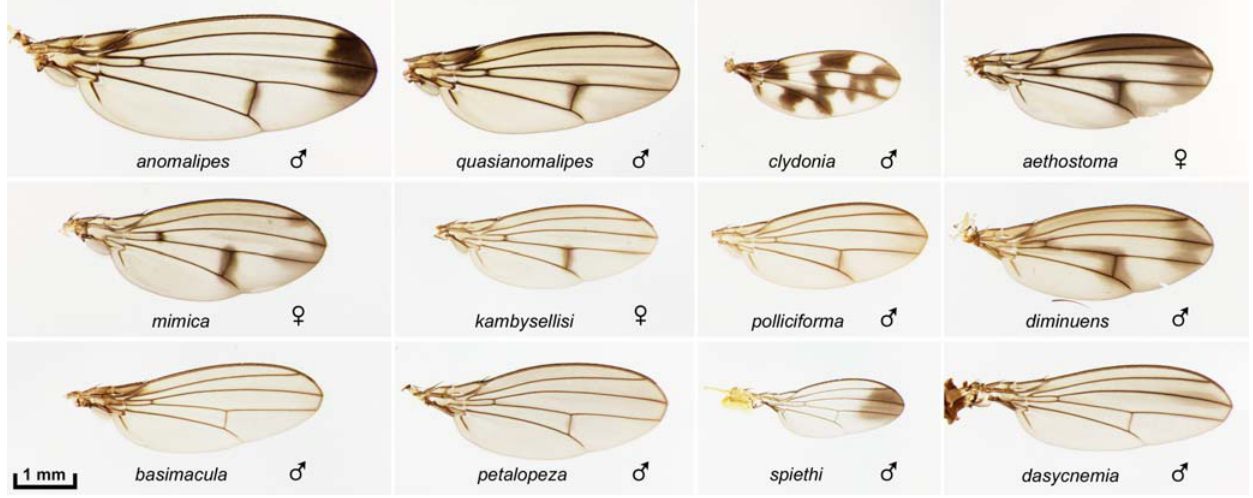
Figure 7. Other non-picture wing species. The anomalipes group: anomalipes and quasianomalipes . ‘‘Modified mouthparts group’’: clydonia, aethostoma, mimica, kambysellisi, polliciforma , and diminuens . The ornate pattern of clydonia is rare among the small, non-picture wing species. The curved L3 vein in clydonia is a characteristic of the species [28]. ‘‘Modified tarsus group’’: basimacula, petalopeza, spiethi , and dasycnemia .